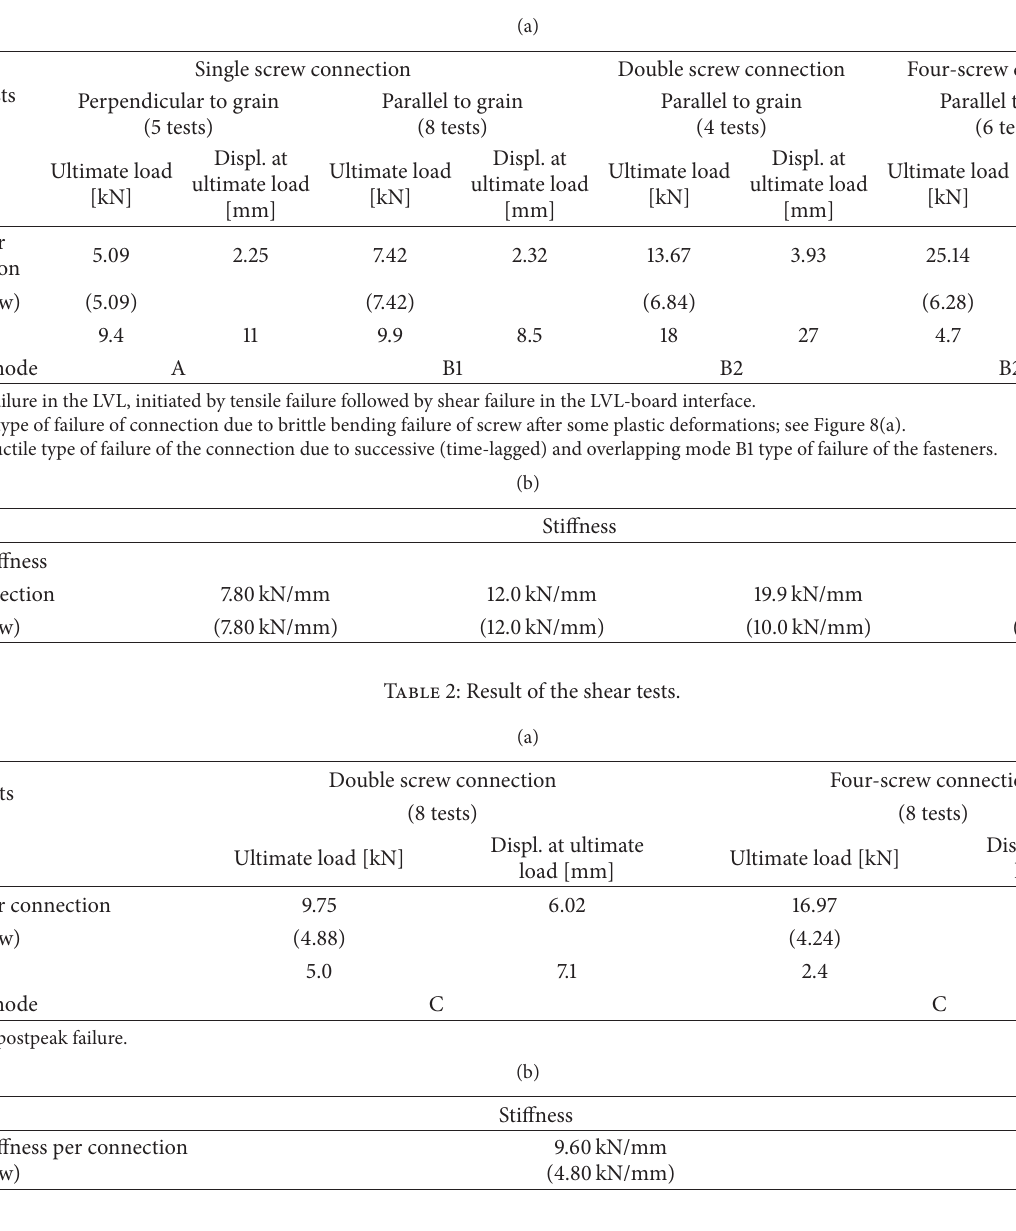
Table 1: Result of the uplift tests parallel and perpendicular (single screw only) to LVL grain (CoV = coefficient of variation; Displ. = displacement).